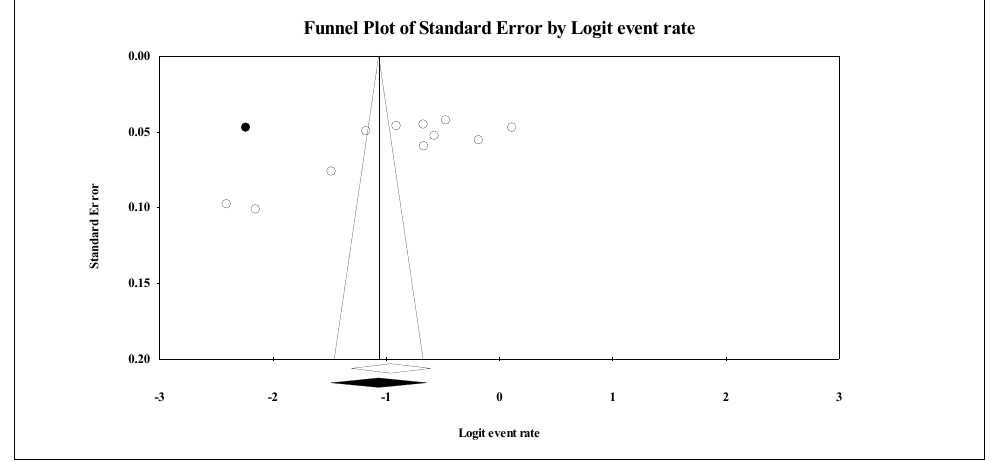
Figure A9. Funnel plot for studies on the prevalence of insomnia (Egger test: P = 0.01; Begg test: P = 0.03). The vertical solid line represents the summary effect estimates.